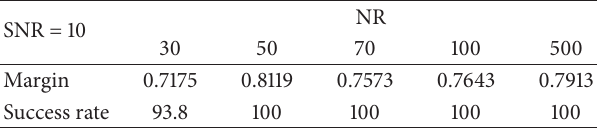
Table 9: The results of using different trial numbers (NR) after denoising, for the condition: speed = 200 Hz and load = 1.8 kN. SNR =